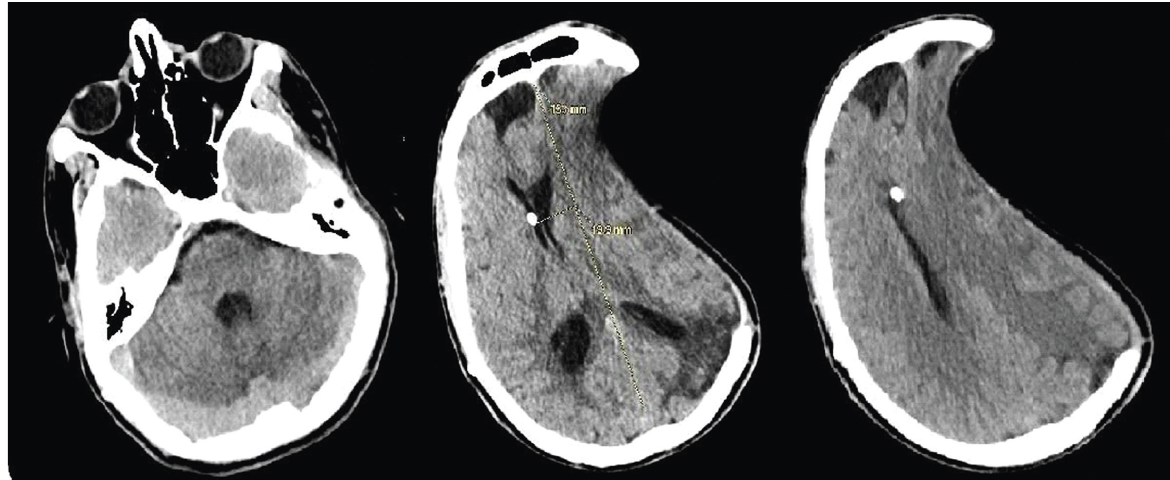
Figure 1: CT head showing left-sided prior craniectomy with significant midline shift.